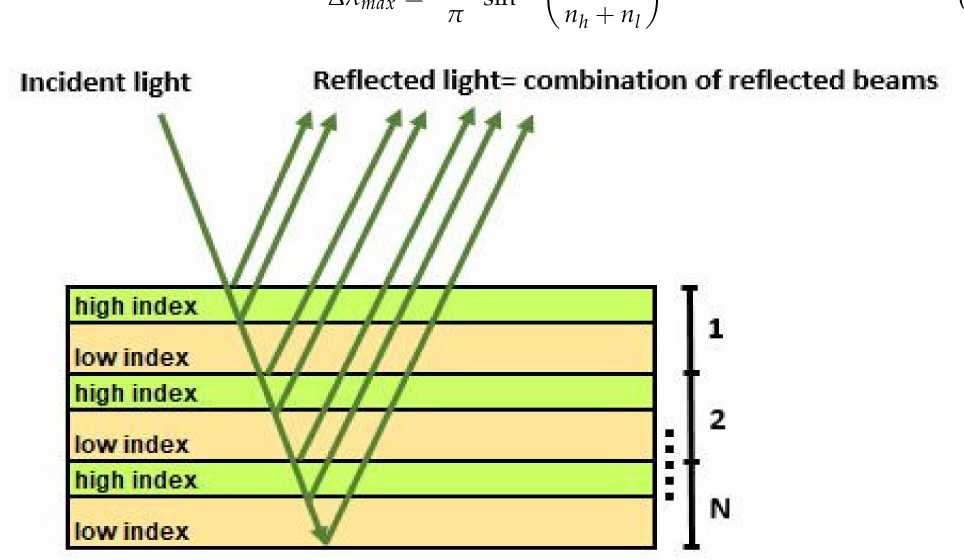
Figure 2. Reflectance of DBR